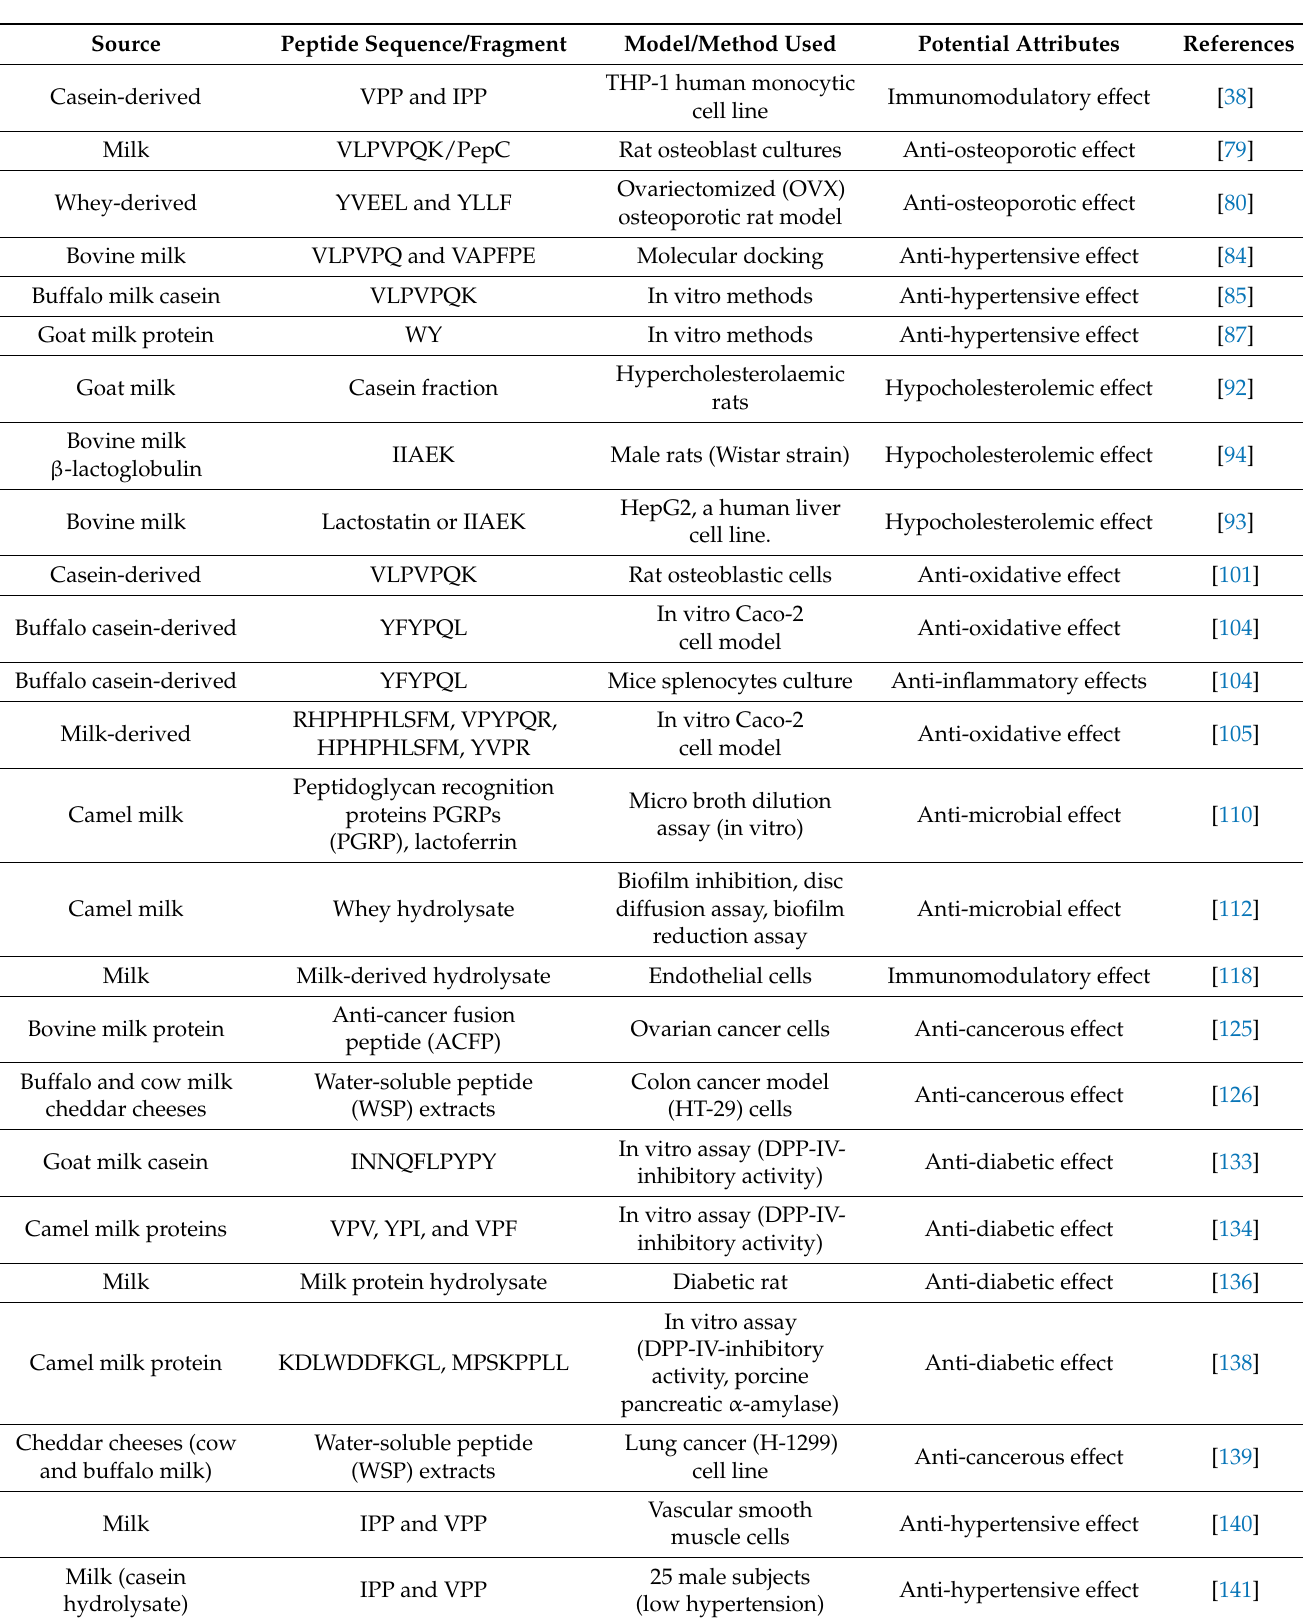
Table 5. Health-promoting and therapeutic attributes of milk-derived bioactive